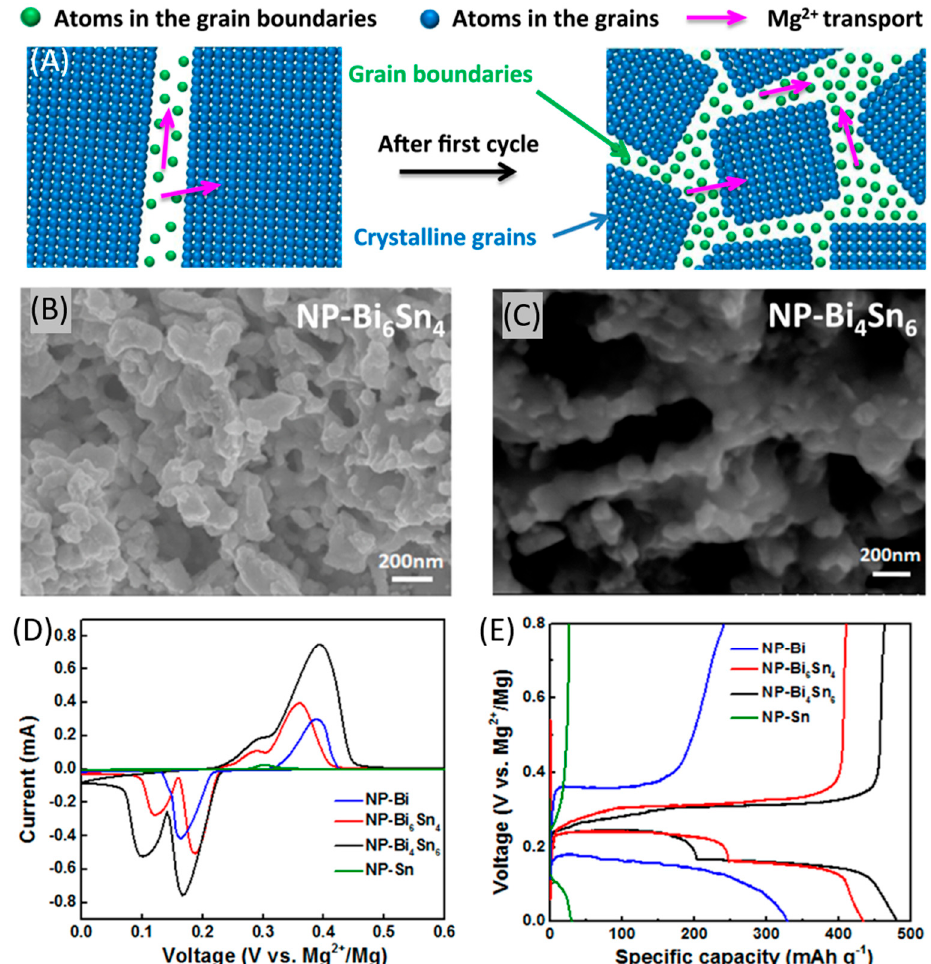
Figure 10. ( A ) The increased grain boundaries on the atomic scale after the fi rst cycle and the en- hanced magnesium ions transport; SEM images of ( B ) NP-Bi 6 Sn 4 and ( C ) NP-Bi 4 Sn 6 ; ( D ) CV curves for NP-bismuth and alloy electrodes at a scan rate of 0.05 mV s − 1 and for NP-tin at 0.01 mV s − 1 for the fi rst cycle; ( E ) Discharge/charge pro fi les for NP-bismuth and alloy electrodes acquired at 50 mA g − 1 and for NP-tin at 20 mA g − 1 . Adapted with permission from [170]. Copyright Elsevier B.V., 2018.